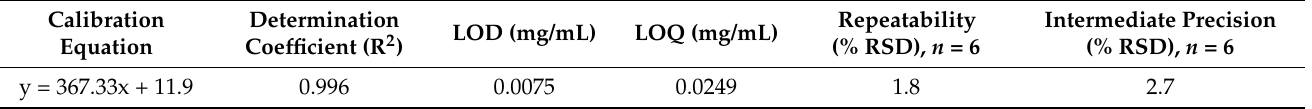
Table 5. Analytical figures of merit of the method regarding calibration data, precision and sensitivity. Calibration Equation